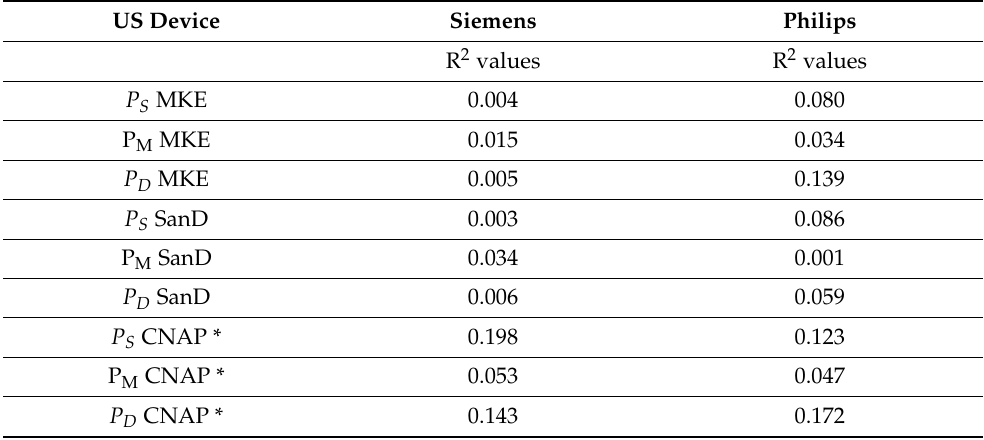
Table 4. The R 2 values for the regressions in Figure 4, demonstrating a small but systematically linear dependency. * marks the group of the CNAP data, which is independent from the US devices. US Device Siemens